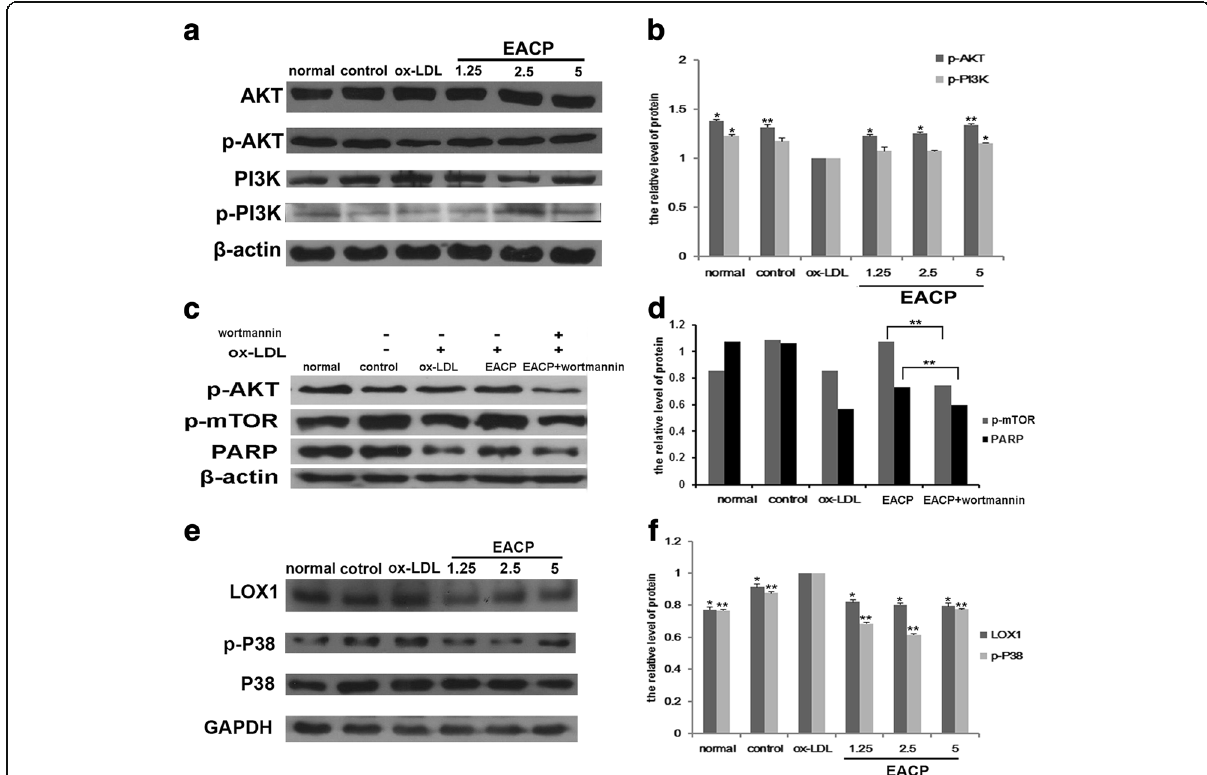
Fig. 5 EACP activated PI3K/Akt and depressed LOX-1/ p38 MAPK in ox-LDL induced HUVECs at 6 h. a , Expression of Akt, p-Akt, PI3K, p-PI3K after treatment with EACP in ox-LDL induced HUVECs at 6 h, respectively; b , Quantification of relative expression quantity of p-Akt and p-PI3K in ox-LDL induced HUVECs at 6 h, respectively. c , Expression of p-Akt, p-mTOR, full length PARP after treatment with EACP combined with wortmannin. d , Quantification of relative expression quantity of p-mTOR and full length PARP after treatment with EACP combined with wortmannin. e , Expression of LOX-1, p38 MAPK, p-p38 MAPK after treatment with EACP in ox-LDL induced HUVECs at 6 h, respectively; f , Quantification of relative expression quantity of LOX-1 and p-p38 MAPK in ox-LDL induced HUVECs at 6 h, respectively. ( * P < 0.05, ** P < 0.01 vs ox-LDL group, n = 3). Data are means ±